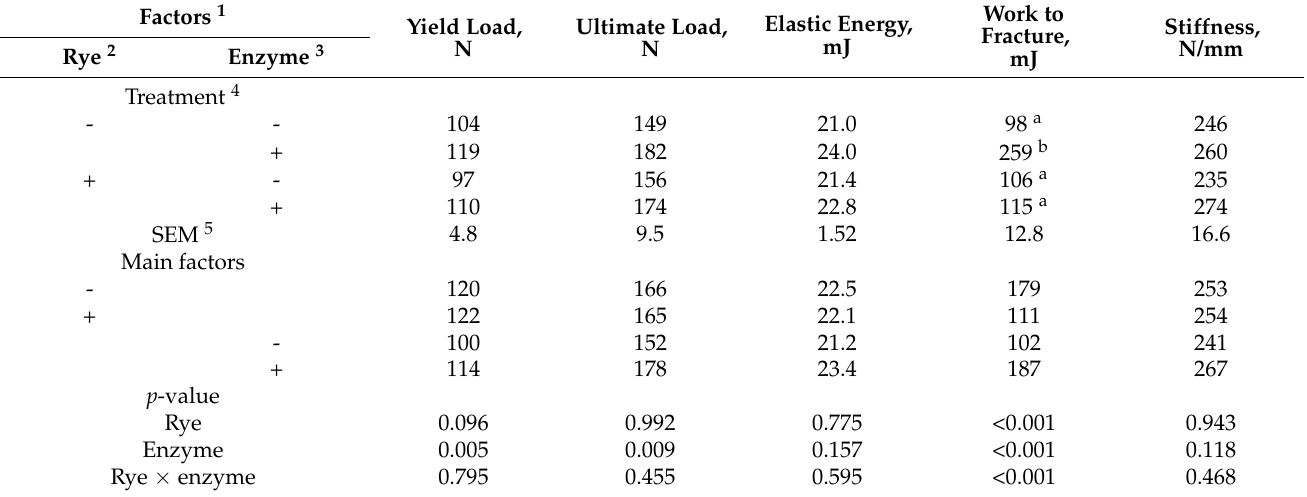
Table 8. Effect of 25% dietary rye inclusion and xylanase supplementation (200 mg/kg of feed) on hens’ tibial mechanical properties and geometrical properties at the end of the laying cycle–bone structural properties.